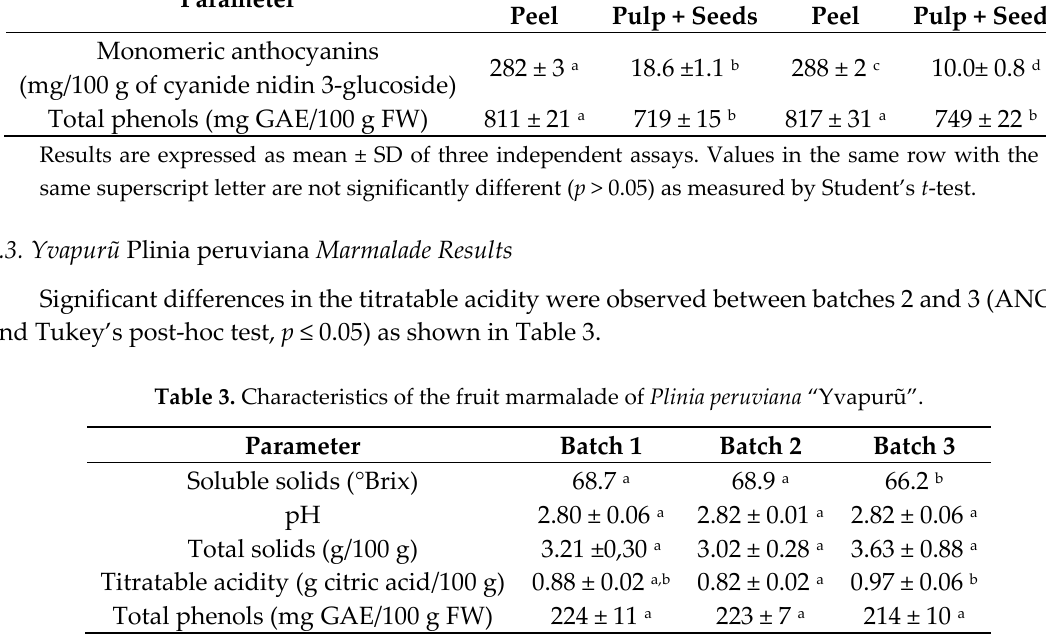
Table 2. Anthocyanins and total phenols in fruits of Plinia peruviana “Yvapur ũ ”. Parameter